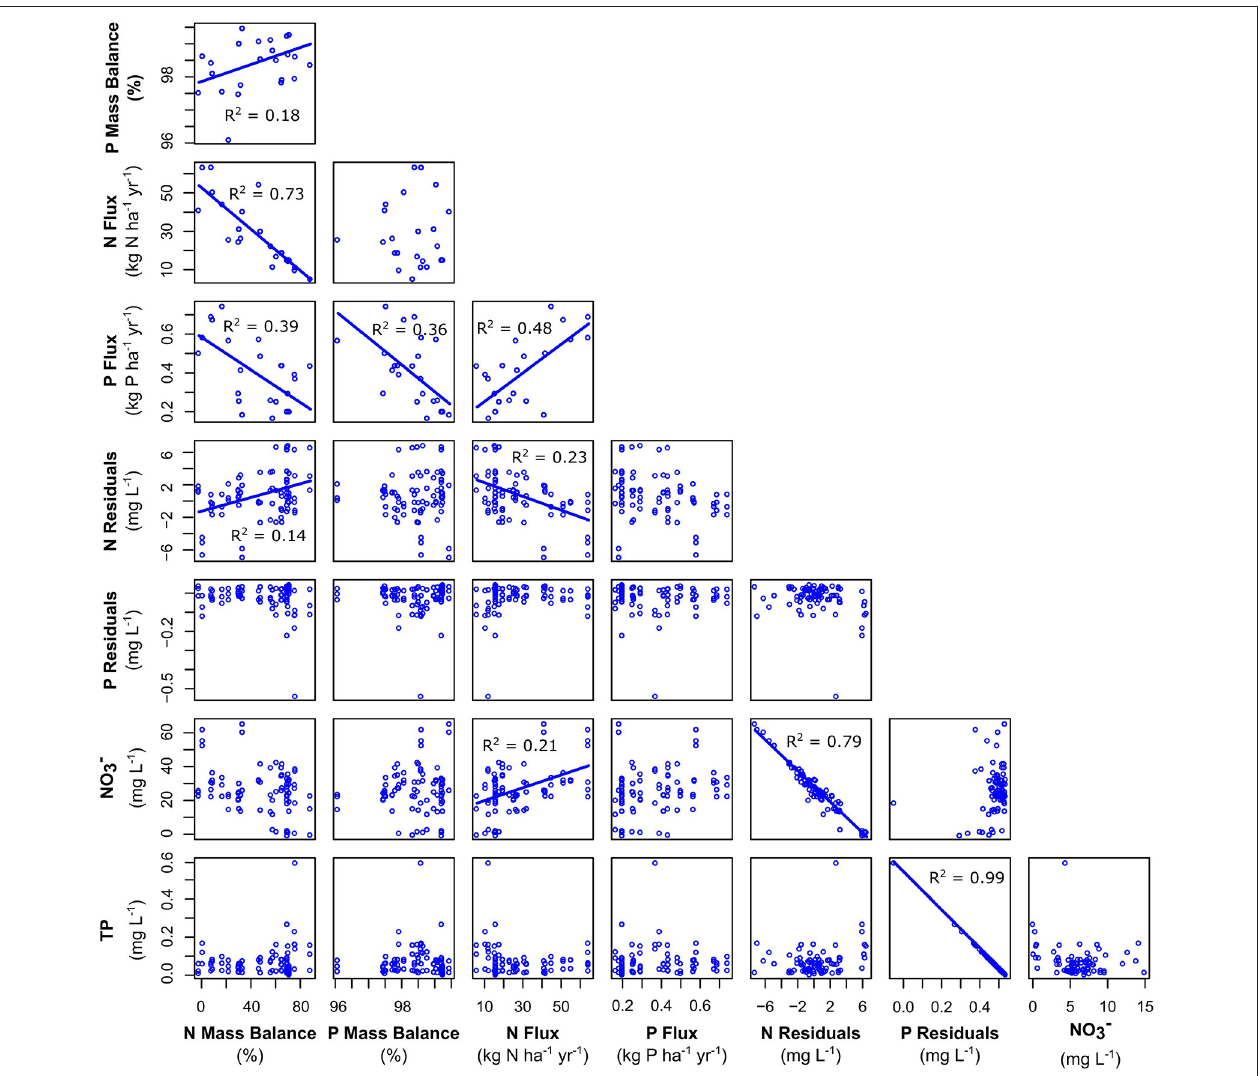
FIGURE 6 | Relationships among our metrics of nutrient attenuation. Here, “Mass Balance” refers to the mass balance estimates of attenuation, “Flux” refers to the fluxes of those nutrients from the watersheds based on concentration and discharge data, and “Residuals” refers to the remaining variation in nutrient concentration after accounting for differences in agricultural land cover ( Figure 3 ). Trend lines for significant correlations ( p < 0.05) are shown and R 2 -values are